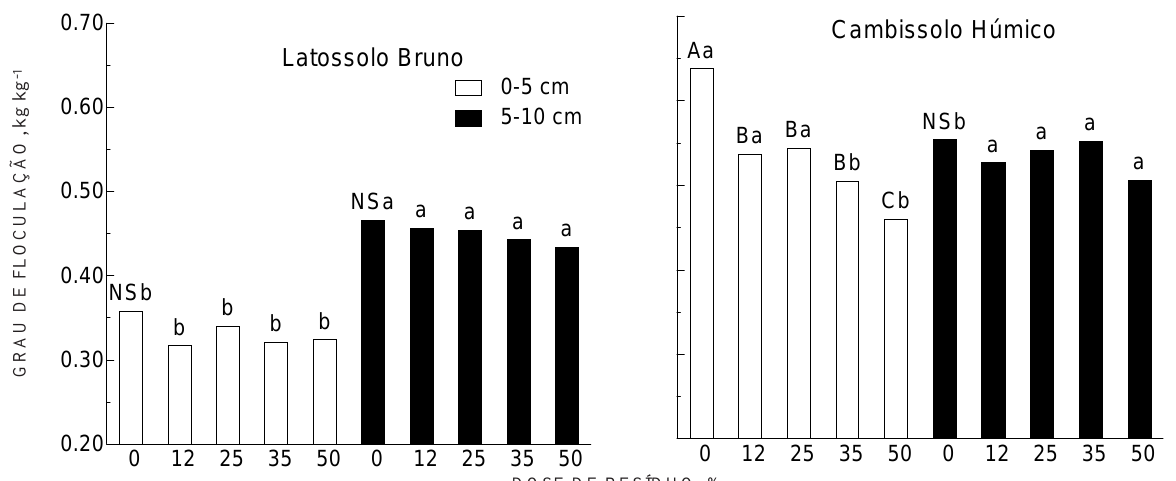
Figura 1. Grau de floculação da argila (GF) do Latossolo Bruno distrófico e do Cambissolo Húmico alumínico, com a adição de resíduo alcalino (% equivalente de CaCO 5 a 10 cm. Letras maiúsculas comparam doses em cada profundidade e minúsculas comparam profundidades em cada dose de resíduo. Letras diferentes indicam diferença significativa (Tukey a 5 %). NS = diferença não significativa.